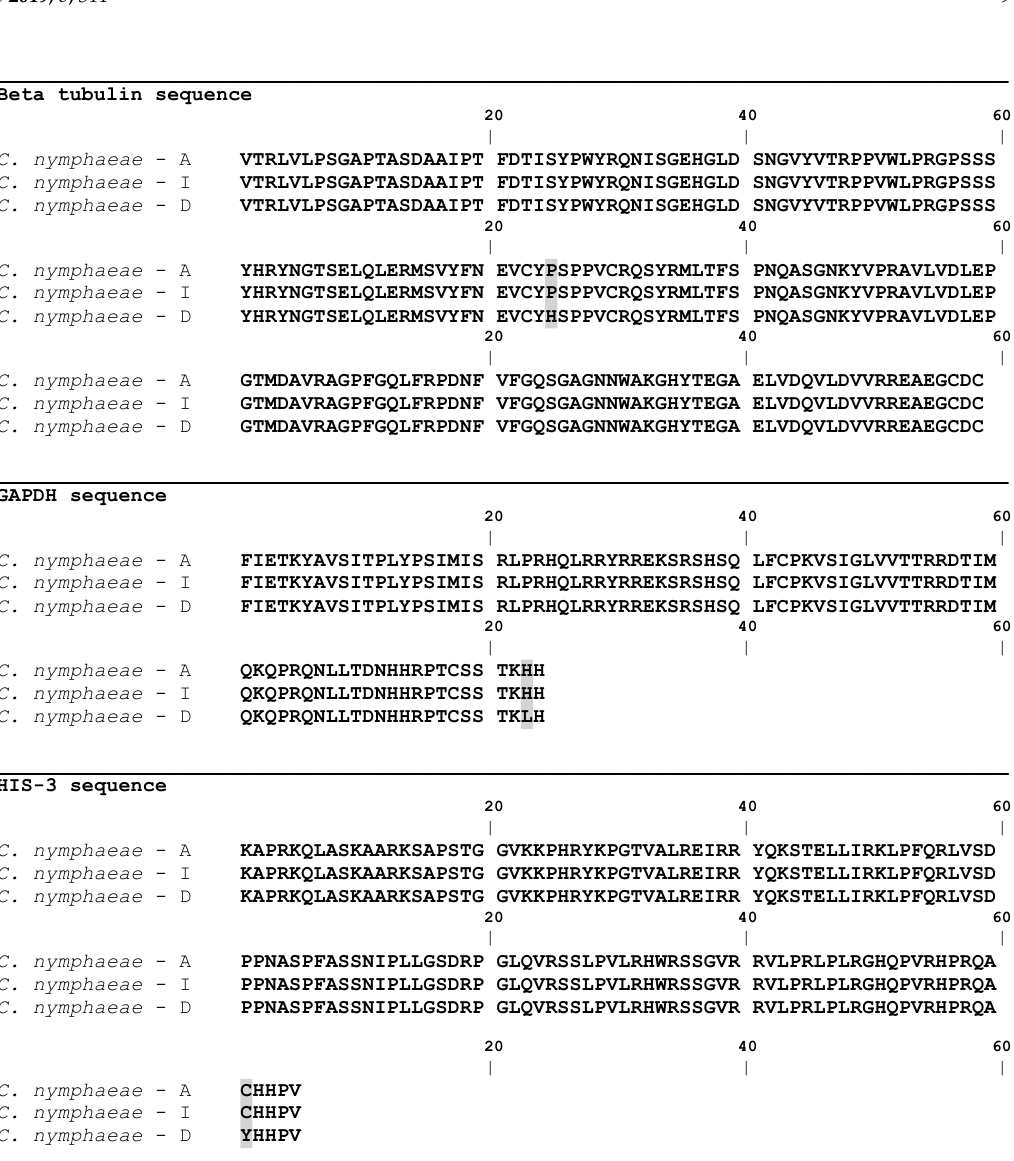
Figure 3. Multiple sequence alignment of the partial Beta tubulin, GAPDH and HIS-3 genes from: C. nymphaeae —( C. nymphaeae sequences from the database), C. nymphaeae —groups A and B, C. nymphaeae —group C, and C. nymphaeae —group D. Differences in the amino acid are shaded.